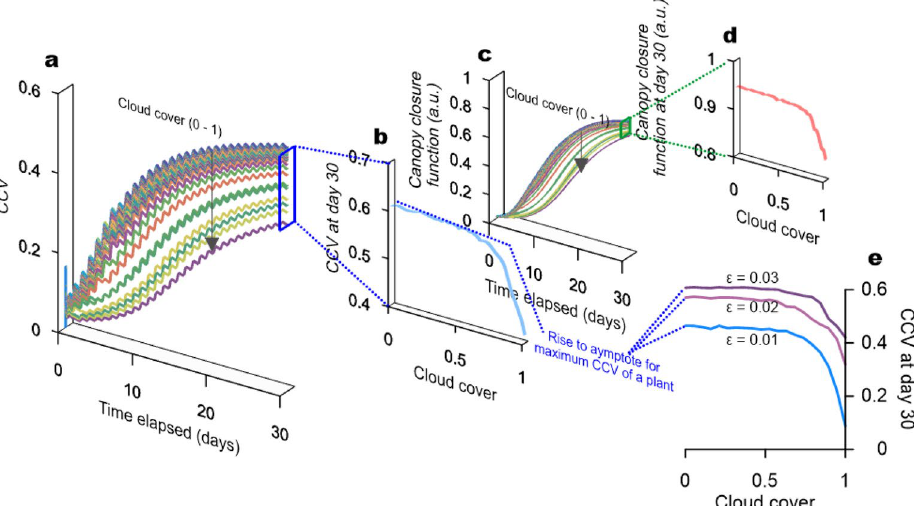
Figure 4. Environment responsive and biophysical characteristics of the CCV curves ( a ) respective CCV progress curves generated by manually increasing the cloud cover value from 0 to 1 and ( b ) cross- sectional graph for CCV versus cloud cover increase at day 30, which shows an asymptotic rise by favorable environmental conditions. Canopy closure progress curve ( c ), cross-sectional graph for the canopy closure versus cloud cover increase at day 30, which is exhibiting an asymptotic rise by favorable environmental conditions ( d ), and distinction between cross-sectional curves for CCV versus cloud cover increases at day 30 according to the parameter manipulating photosynthetic efficiency ( ε ) ( e